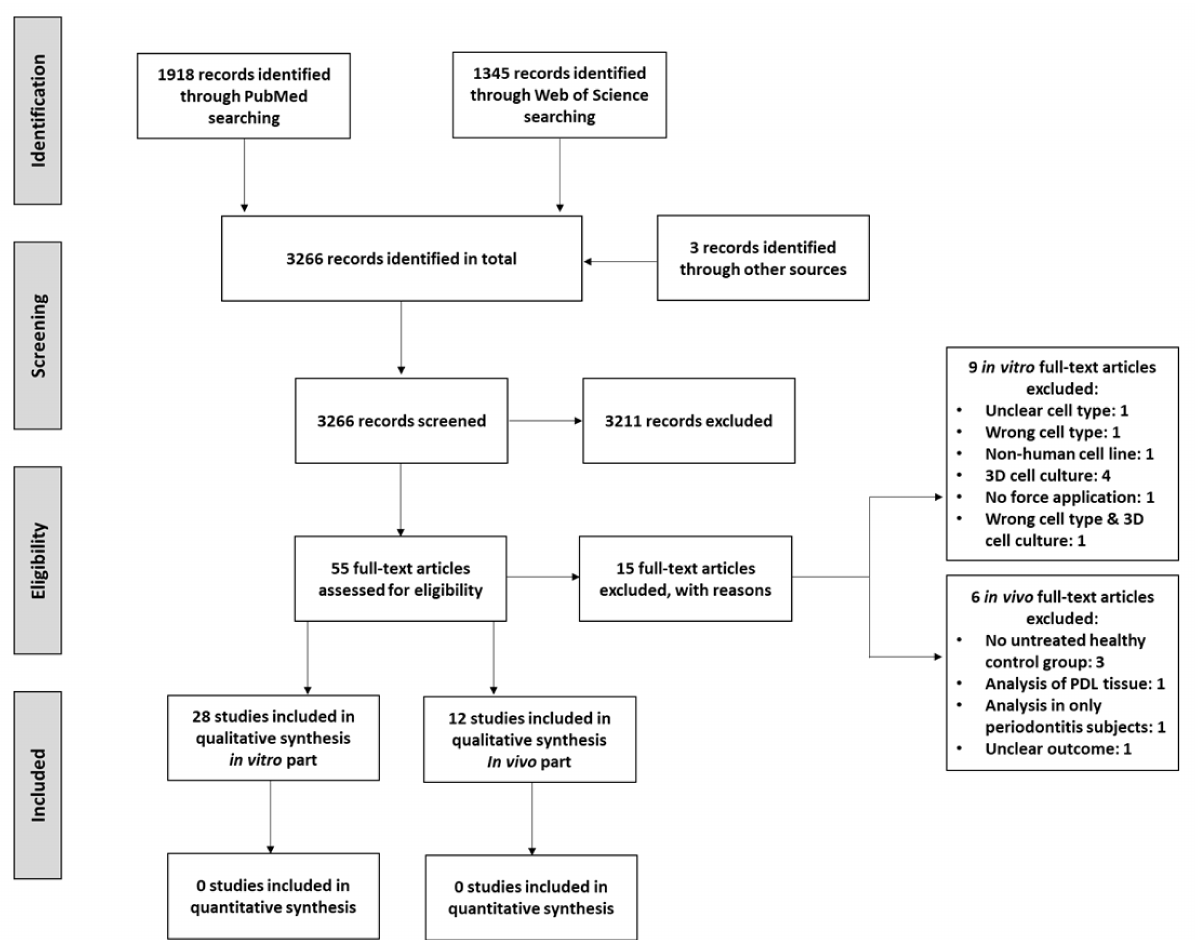
Figure 1. PRISMA Flow Diagram presenting the systematic search